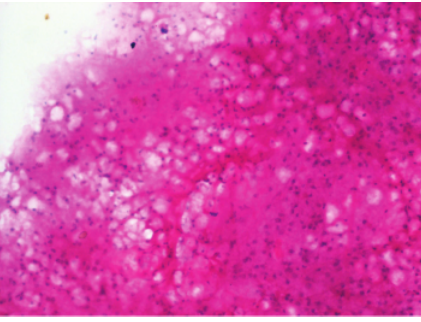
Figure 1: Multiple blue nuclei in a fibrillary background (H&E, × 400).